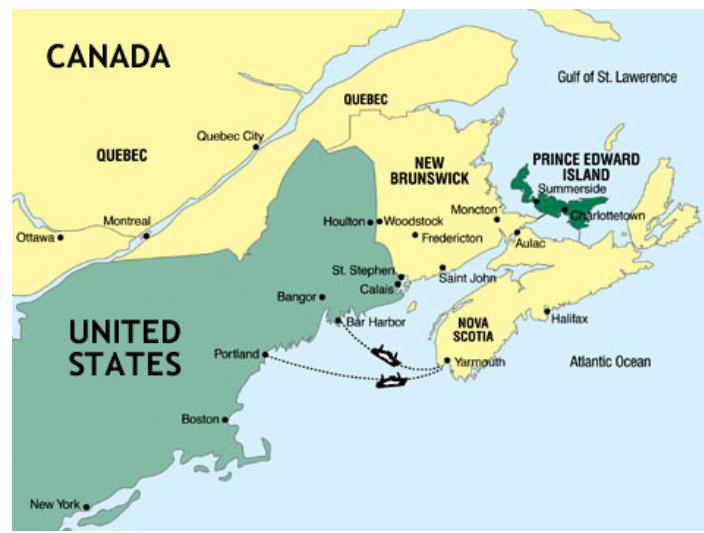
Figure 1. Prince Edward Island Location. (PEI Government Map).